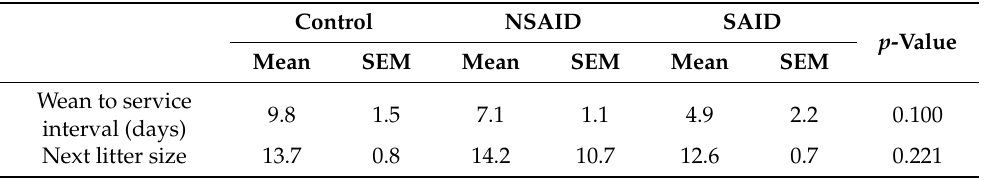
Table 4. Effects on subsequent reproductive performance for sows injected with saline (Control), a nonsteroidal anti-inflammatory (NSAID) or steroidal anti-inflammatory (SAID) prior to the previous farrowing event; means ±